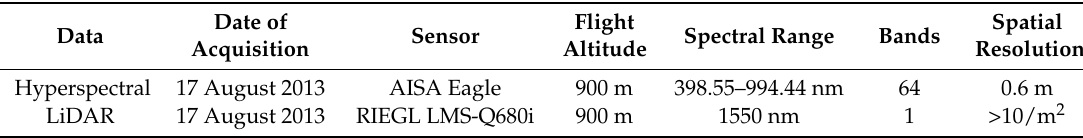
Table 2. Specifications of hyperspectral and LiDAR data